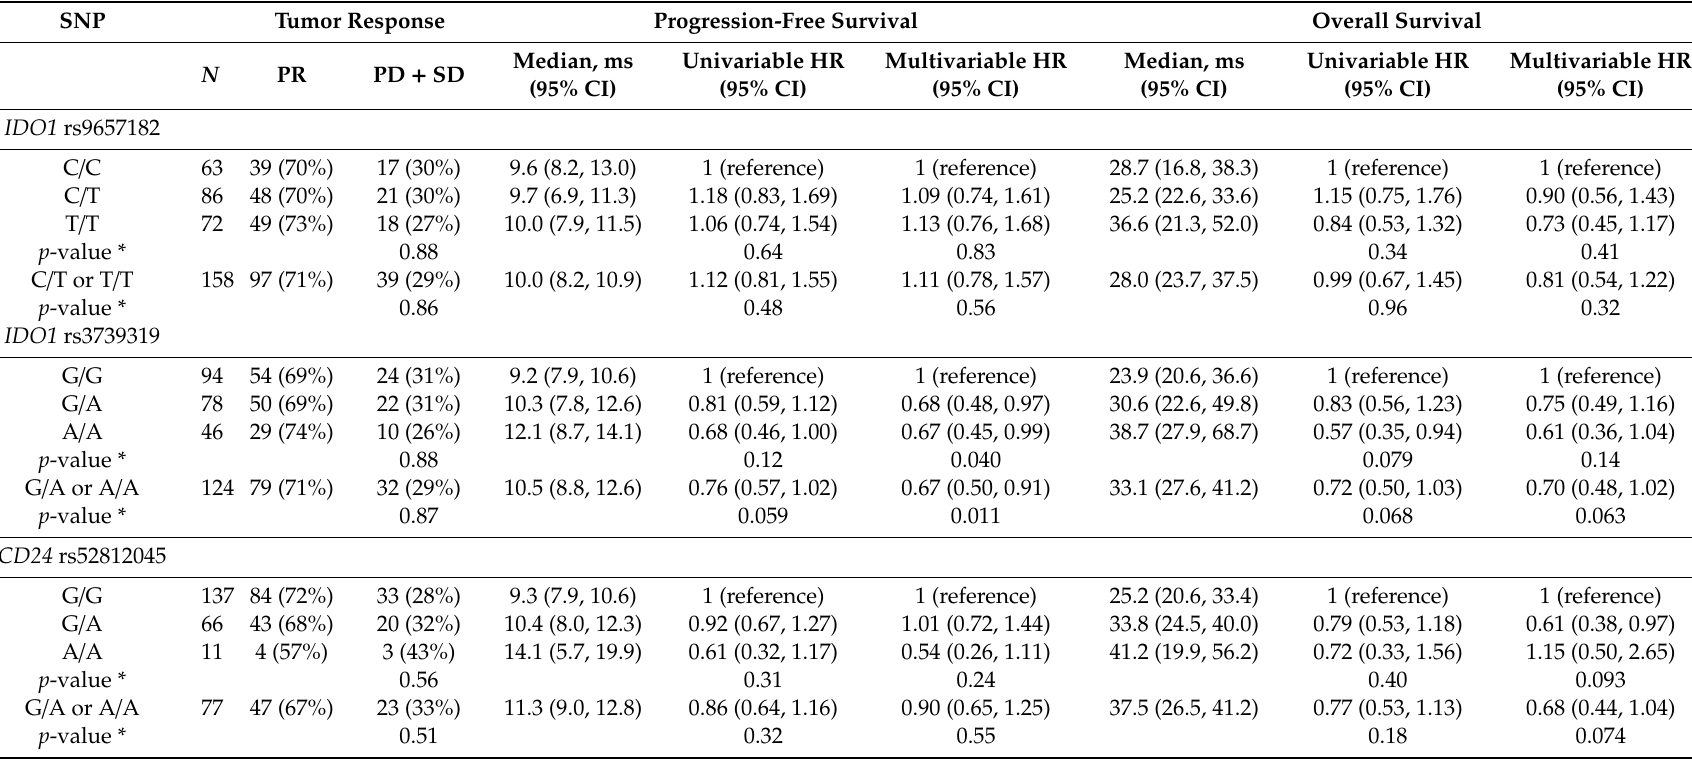
Table 3. Immune regulatory SNPs and outcomes in patients receiving first-line FOLFIRI and cetuximab in FIRE-3 (validation cohort